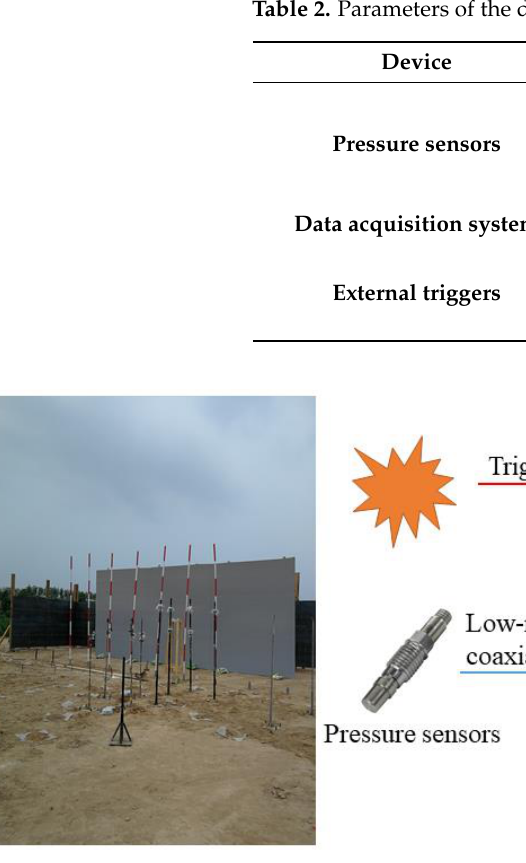
Figure 3. Schematics of the test system and a photo of the experiment site.